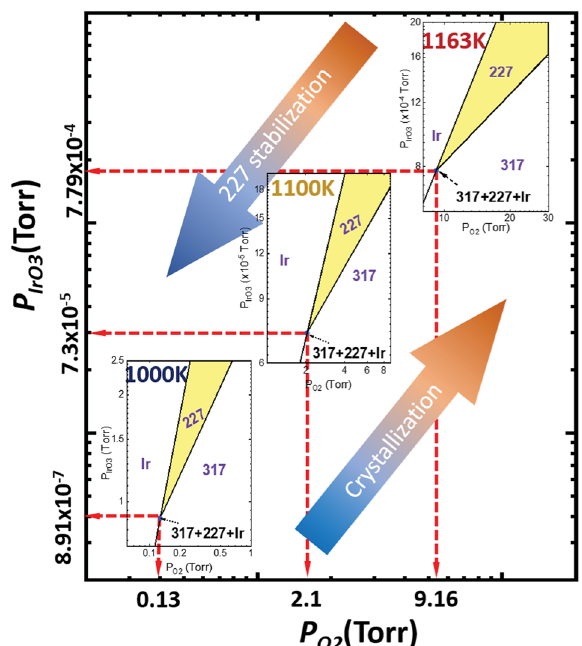
Fig. 5 Calculated potential phase diagrams of the Pr-IrO 3 -O 2 system at 1000, 1100, and 1163 K. In the calculated phase diagrams, the points represent three-phase equilibria, the lines two-phase equilibria, and the areas one-phase equilibria. The dashed red arrows indicate the minimum requirement of IrO 3 and O 2 partial pressures for the 227